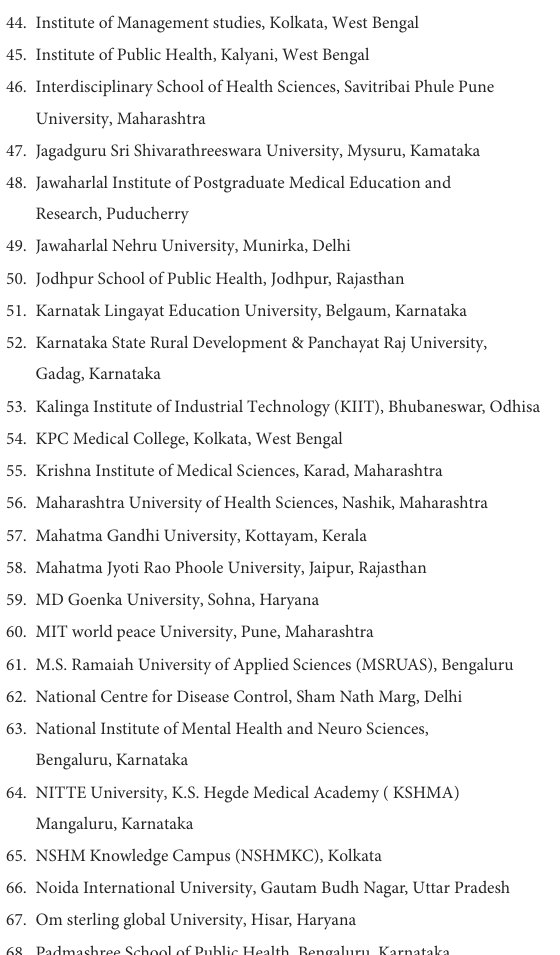
TABLE 1 List of institutions offering public health education in SAARC